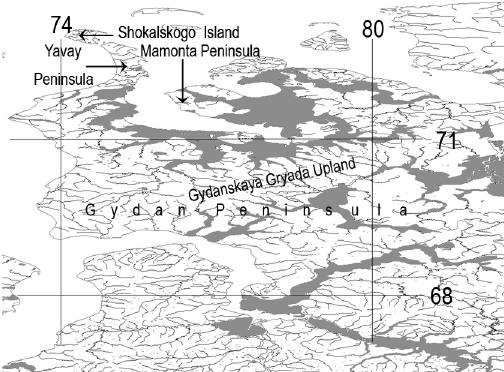
Fig. 7. Map of Basins of Agapa and Mokhovaya Rivers, Hills along Upper Agapa River, and Between Pura and Agapa Rivers calving grounds.